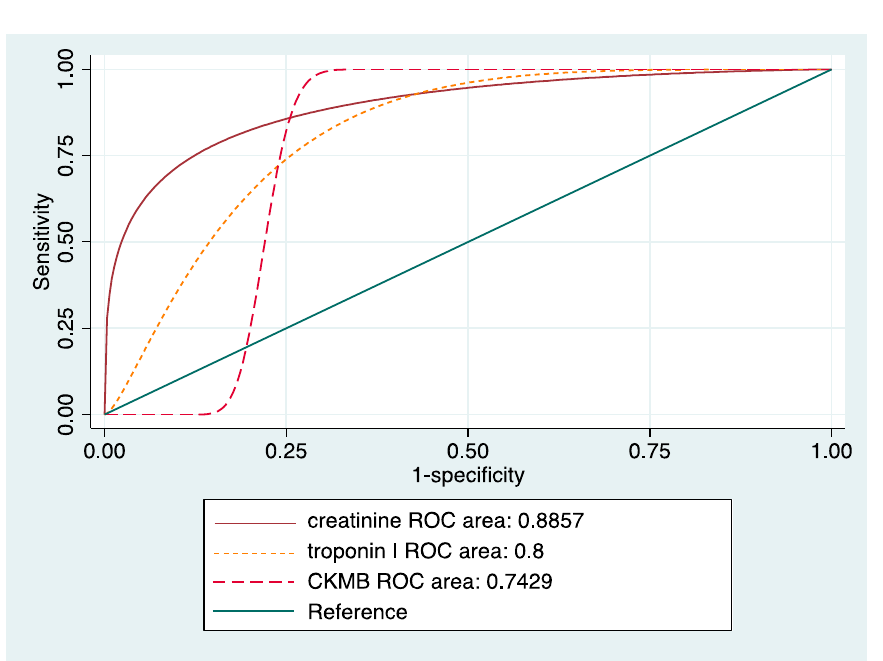
Figure A1. Receiver operating characteristic curve: Differences of serum CK-MB, troponin I, and creatinine within 24 h before and after ECMO cannulation in predicting in-hospital mortality.